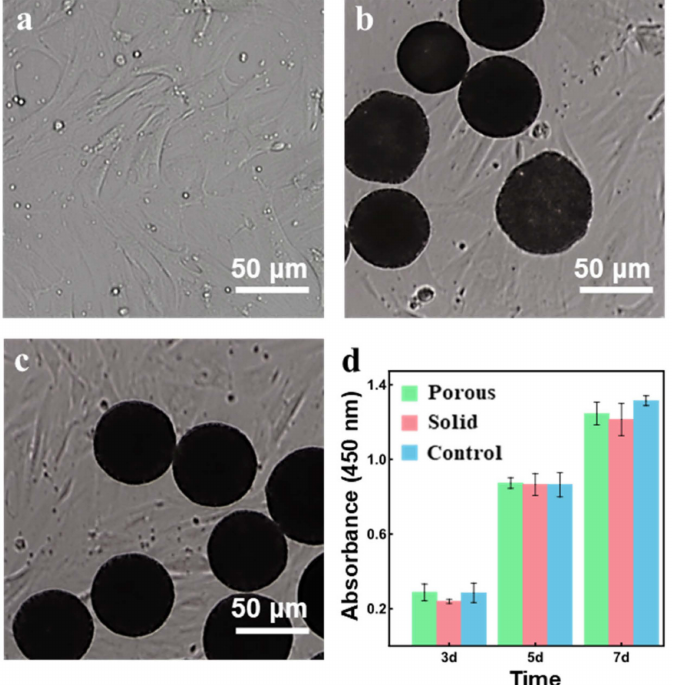
Figure 7. ( a ) rBMSCs alone and co-cultured with solid ( b ) or porous ( c ) microspheres at 7d; ( d ) cell activity and proliferation of rBMSCs during the